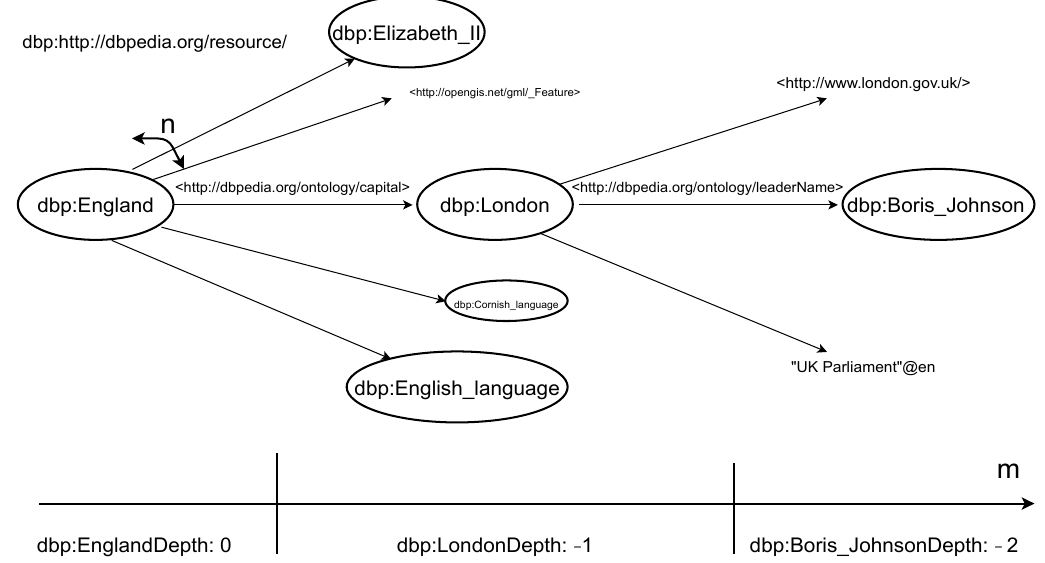
Figure 1. n : average number of predicates connected to entity m , distance from entity A to